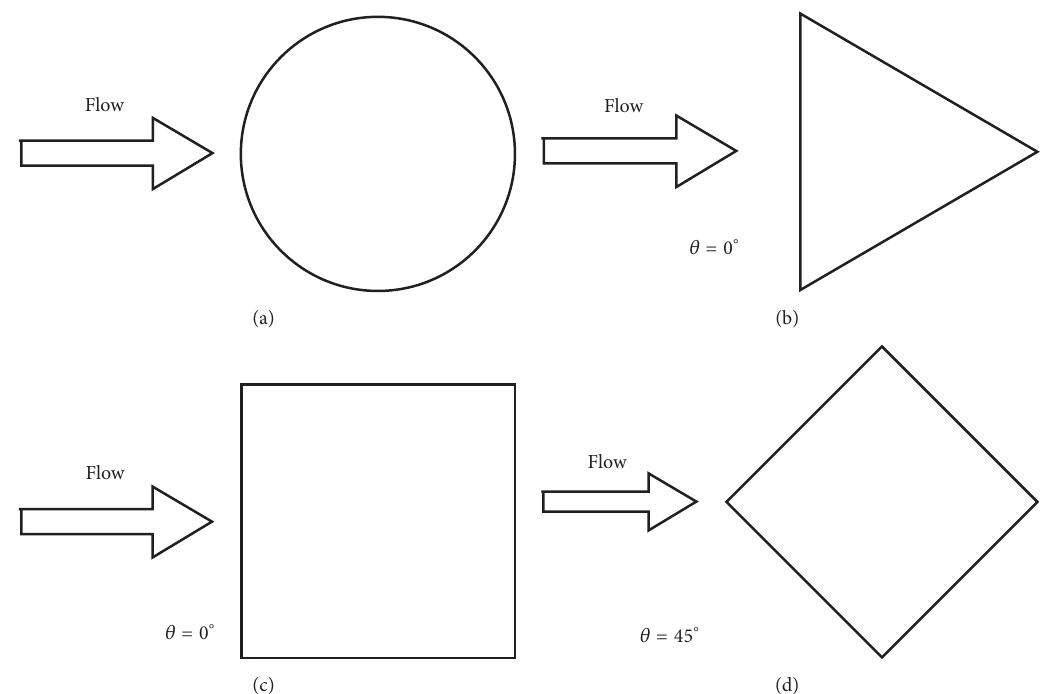
Figure 5: The incident angle to the flow direction for different cylinders. (a) Circular cylinder; (b) regular triangle prism; (c) right square prism; (d) diamond square prism.